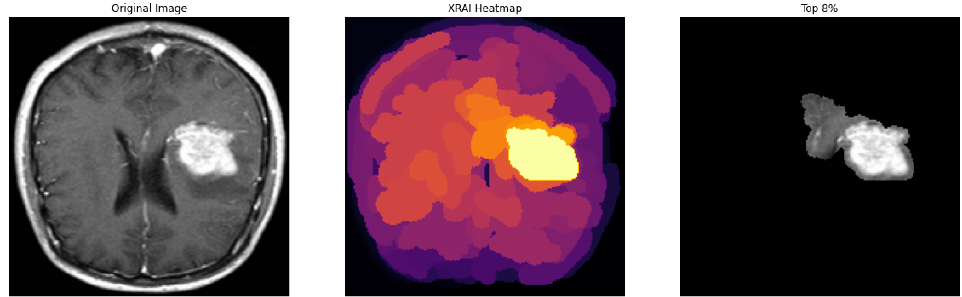
Figure 10. XRAI heatmap explanation for brain tumour detection and classification with the top 8% of the salient of the